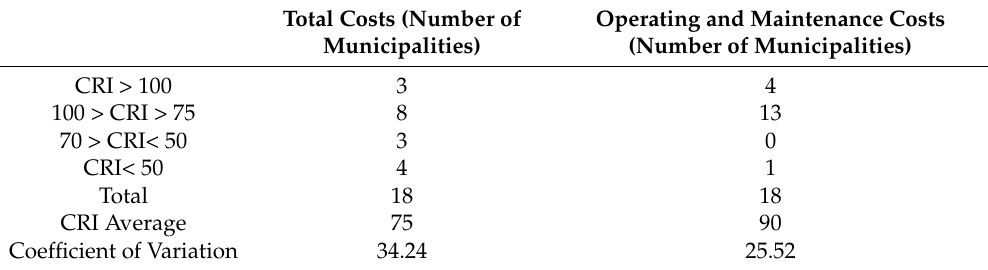
Table 7. Cost recovery index (CRI) per number of